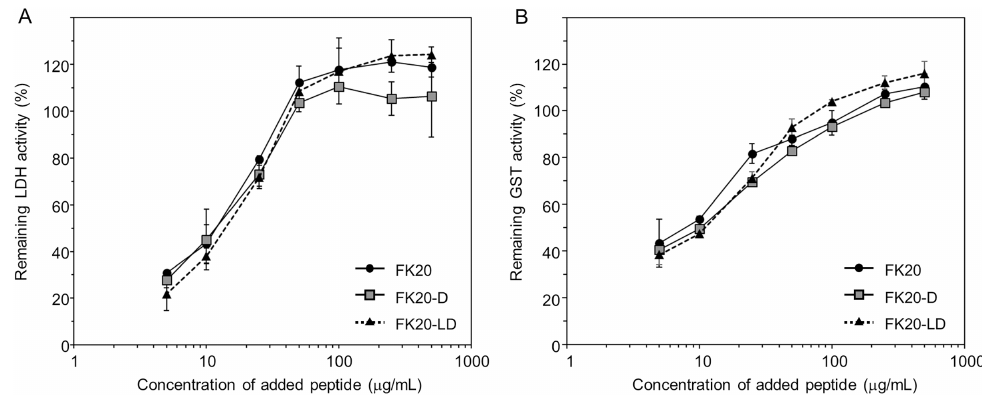
Figure 3 Cryoprotective activity of IDP-derived peptide FK20 and its all D-enantiomeric isomer FK20-D towards LDH and GST. Cryoprotective activity of IDP-derived peptide FK20 and its all D-enantiomeric isomer FK20-D towards LDH (A) and GST (B) (A) LDH activities were plotted ( fi nal concentration of 50 µg/ml) after freeze-thawing in the presence of additive IDP peptides of concentrations ranging from 2.5 to 500 m g/ml. The LDH activity of the untreated sample was set to 100%. FK20: fi lled circle, FK20-D: grey square. (B) GST activities were plotted ( fi nal concentration of 280 µg/ml) after freeze-thawing in the presence of additive IDP peptides of the concentration ranging 2.5 to 500 m g/ml. The GST activity of the untreated sample was set to 100%. FK20: fi lled circle, FK20-D; grey square, FK20-DL (equimolar mixture of FK20 and FK20-D): fi lled triangle with dashed